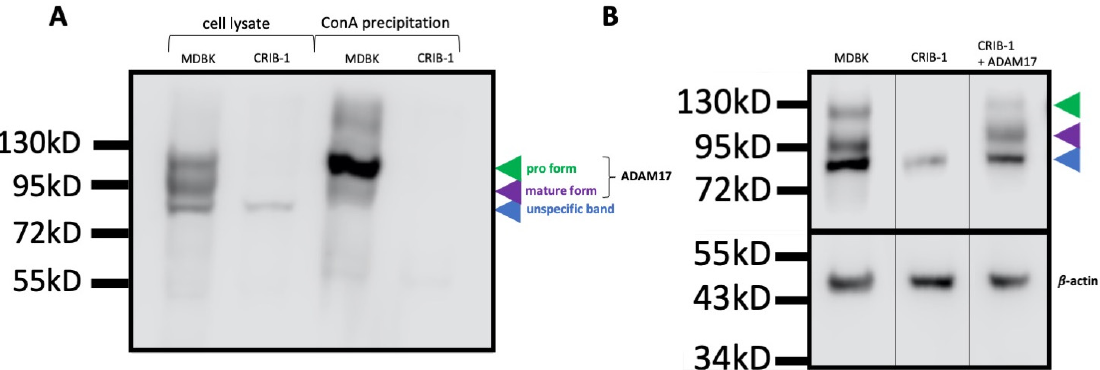
Figure 1. Glycosylated forms of ADAM17 are absent in CRIB-1 cells. ( A ) Western blot analysis of ADAM17 in the cell lysate of MDBK and CRIB-1 cells and in the cellular glycoprotein fraction of MDBK and CRIB-1 cells generated by precipitation with Concanavalin A (ConA) beads. The different bands are indicated by arrow heads. In CRIB-1 cells, only the band designated as unspecific, as its origin is unknown, can be discerned in cell lysate, whilst no band can be detected when glycoproteins are precipitated with ConA beads. ( B ) Detection of ADAM17 and β -actin by Western blot analysis of cell lysates of MDBK, CRIB-1 and CRIB-1 cells expressing ADAM17 from a lentiviral vector (+ADAM17). Upon transcomplementation, the glycosylated pro- and mature form of ADAM17 can be detected in CRIB-1 cells, indicating that the pathways responsible for glycosylation and processing of ADAM17 are intact in CRIB-1